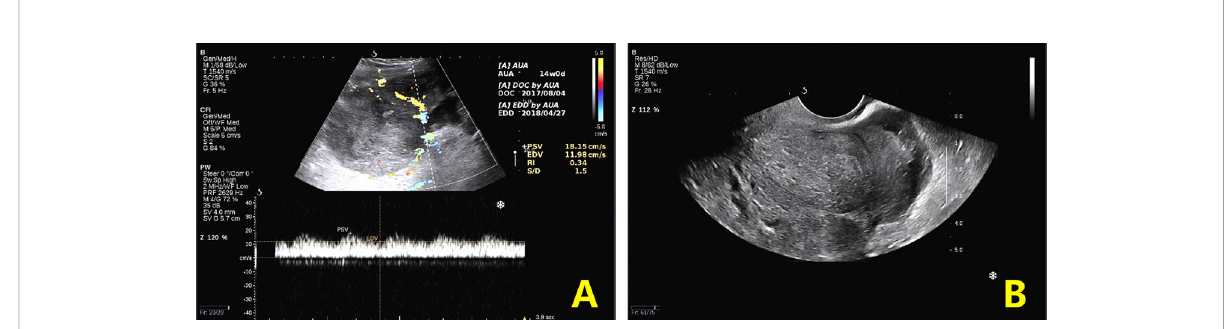
FIGURE 1 Preoperative ultrasound fi ndings. (A) . Transabdominal ultrasound: cross-section view shows a heterogeneous echogenic mass and internal venous and low-resistance arterial blood fl ow spectrum. (B) . Transvaginal ultrasound: longitudinal section of the uterus showing a posterior uterus in the center surrounded by heterogeneous